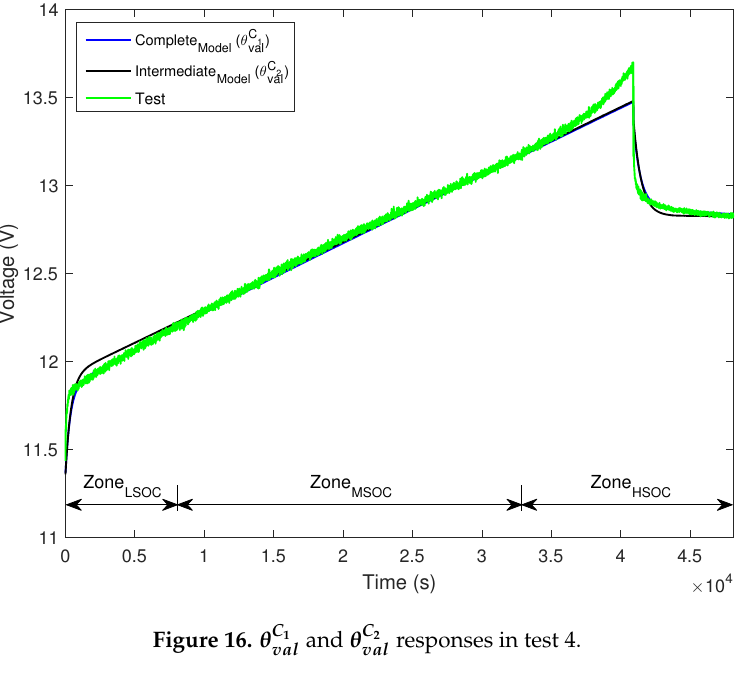
responses in test 4. and θ C 2 val val